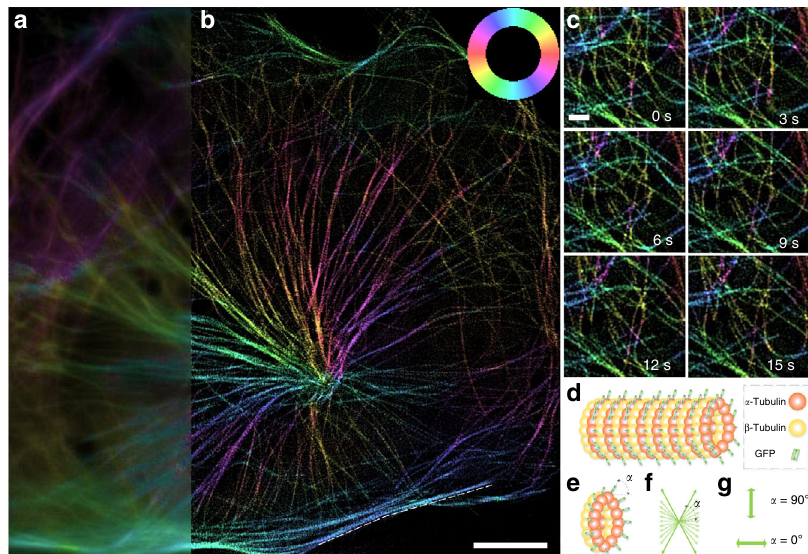
Fig. 5 Live-cell imaging of the microtubules in U2OS cells. a , b 3D-pSIM images, obtained at 0.67 reconstructed fps, of the microtubules in a live U2OS cell (80 × 80 × 0.75 μ m 3 ) expressing tubulin-GFP. The maximum intensity projection (MIP) images for PM ( a ) and pSIM ( b ) are compared. 3D-pSIM images the in-plane dipole orientation together with doubled lateral and axial resolution as that of PM. c Time-lapse 2D sections of the 3D-pSIM results. d Schematic of the α -tubulin-GFP structure. The orientation of the ensemble dipole is perpendicular to the microtubule fi lament. e – g The ensemble dipole consists of a 2D in-plane projection of all the 3D GFP dipoles. The relative orientation between the GFP dipole and the α -tubulin monomer determines whether the ensemble dipole is perpendicular or parallel to the fi lament. If the included angle α between the GFP dipole and the microtubule fi lament is close to 90° (or 0°), then the averaged dipole orientation is perpendicular (or parallel) to the fi lament. Scale bars: a 10 μ m and ( b ) 1 μ